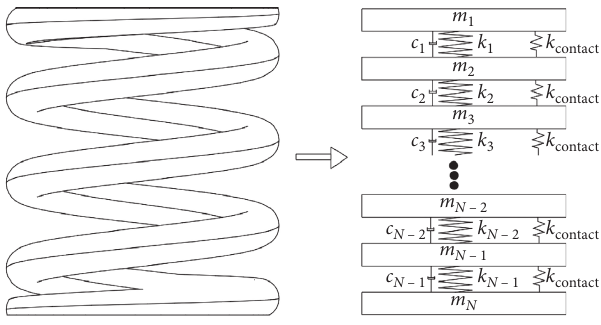
Figure 1: Mass-spring series equivalent